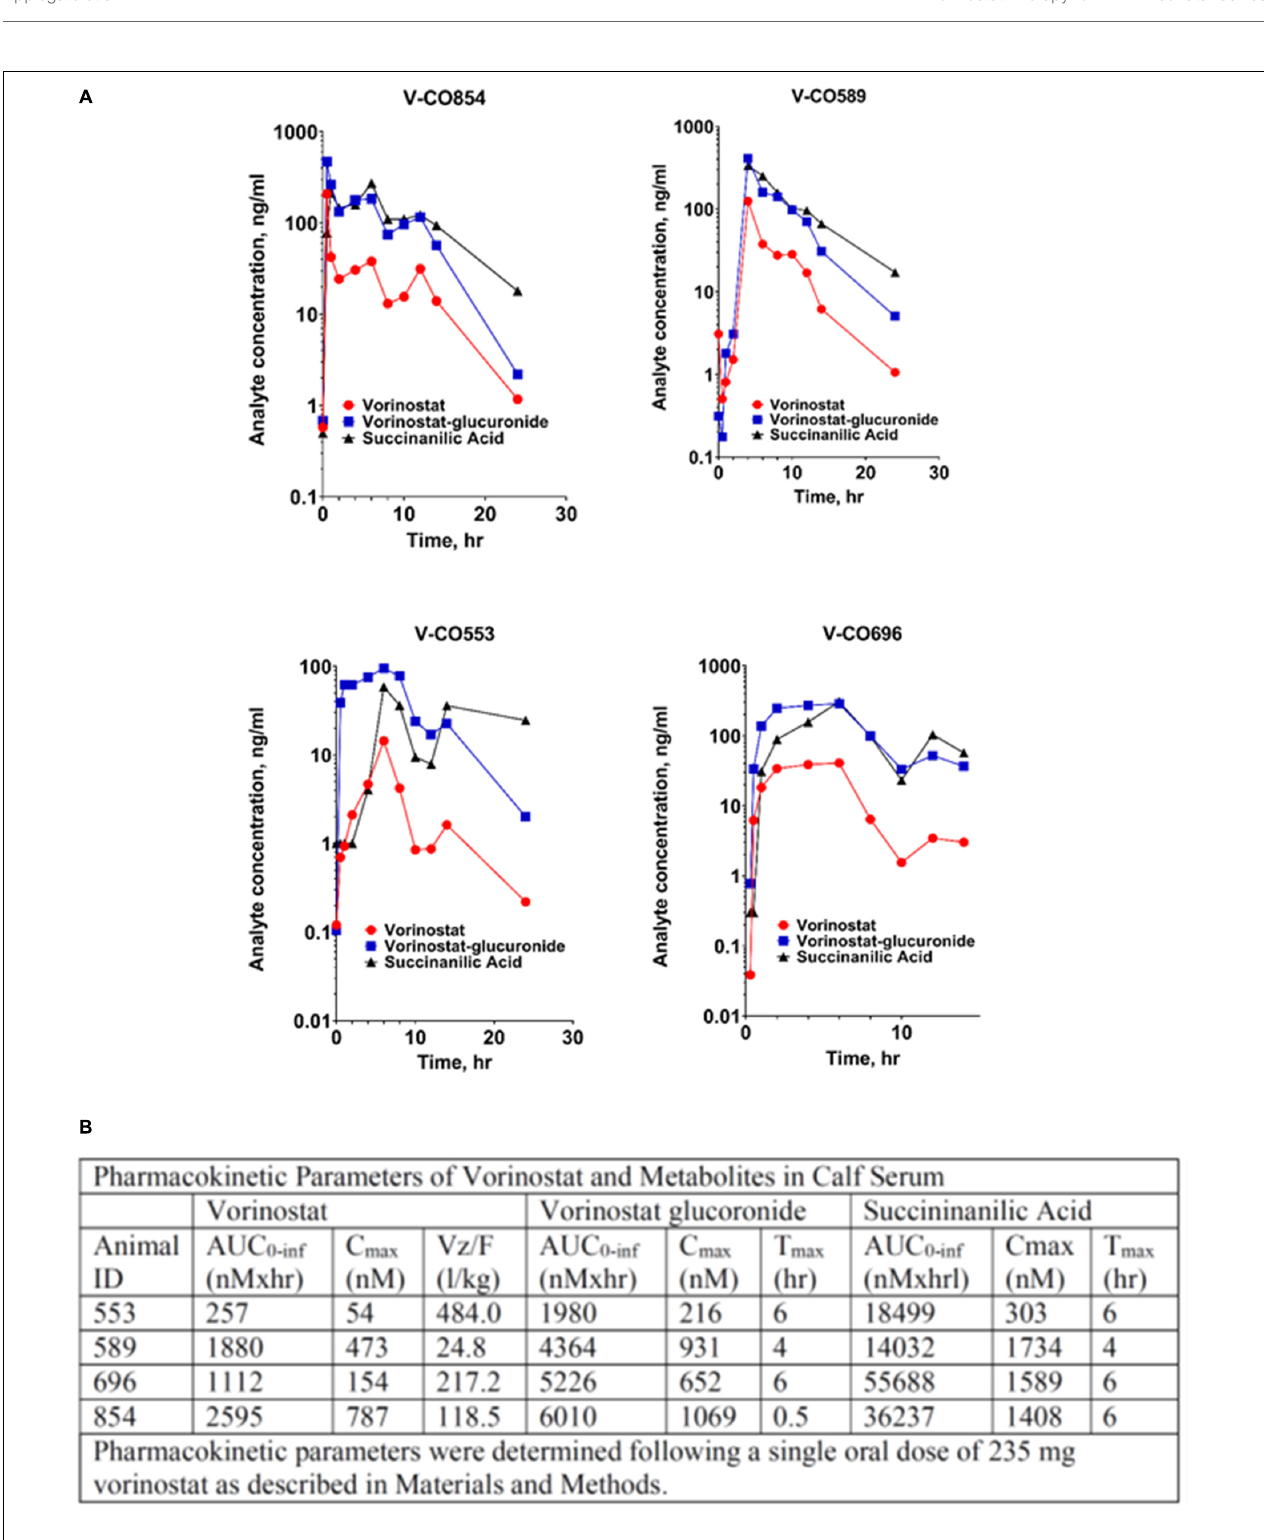
FIGURE 4 | Pharmacokinetics of vorinostat administration and metabolism in calves. (A) Serum concentrations of vorinostat and metabolites following oral dosing. Vorinostat (235 mg) was administered orally. Blood was drawn at indicated intervals and analyzed for vorinostat and its metabolites as described in section “Materials and Methods.” Data from four replicate animals are shown. (B) Pharmacokinetic parameters of vorinostat and metabolites. Pharmacokinetic parameters were calculated from the time course data in A as described in section “Materials and Methods.” AUC, area under the curve, integrated sum of total amount of analyte; Cmax, maximum serum concentration; Tmax, time of maximum serum concentration; Vz/F, volume of distribution normalized to oral bioavailability.